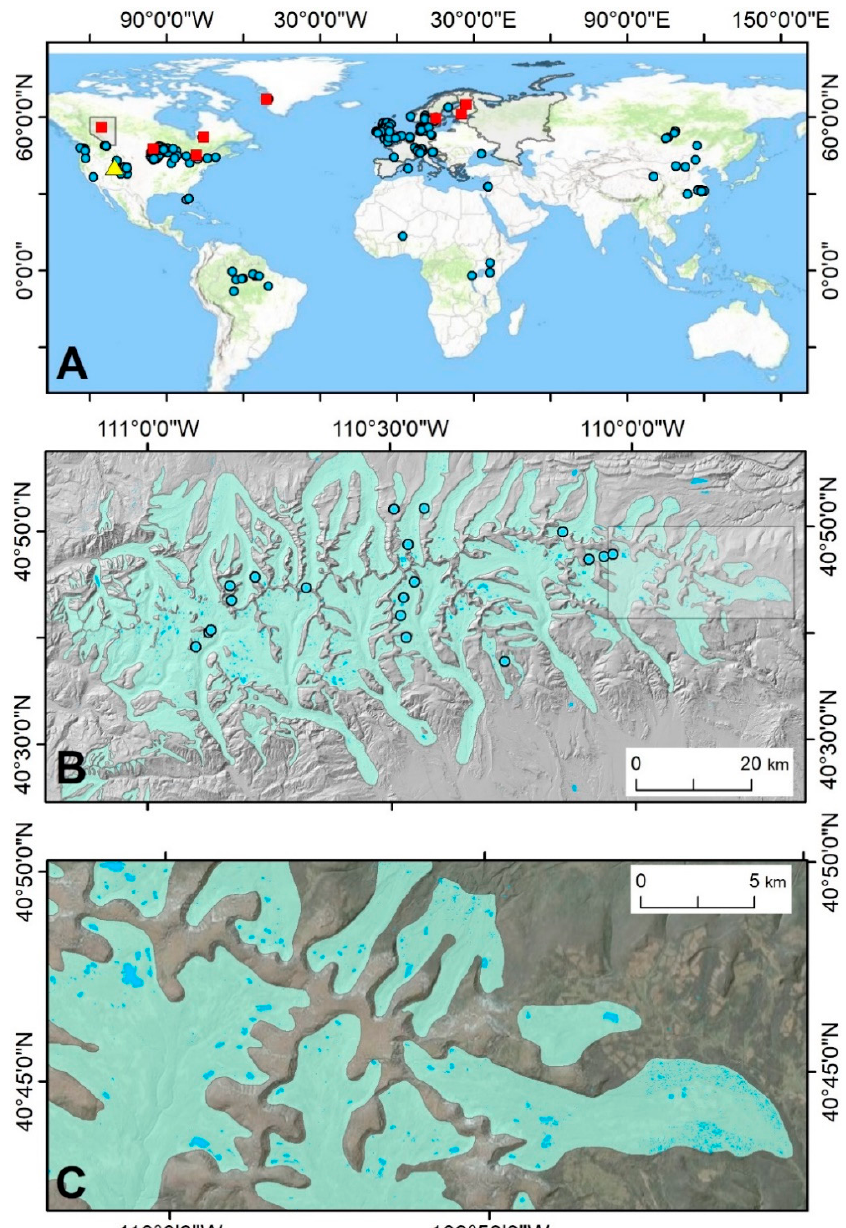
Figure 1. Location of the study area. ( A ) Global distribution of previous studies that calculated rates of carbon accumulation in lakes. Red squares represent Holocene-length studies, along with shading for Alberta, Canada [20] and various European countries where studies have been completed [10]. Blue dots represent locations where modern rates of carbon burial in lakes have been calculated, as summarized in recent work [15]. The yellow triangle marks the location of the Uinta Mountains in the western US. ( B ) Lakes of the Uinta Mountain range in Utah (denoted by the yellow triangle in Panel A) displayed over a digital elevation model with hillshading to accentuate topography. Areas covered by glaciers at the Last Glacial Maximum (LGM) are shown in green [26]. Cored lakes are marked with circles and the box delineates the inset. ( C ) Inset showing typical lake density in the Uinta Mountains displayed over a true-color aerial image with hillshading. Areas covered by glaciers during the LGM are shown in